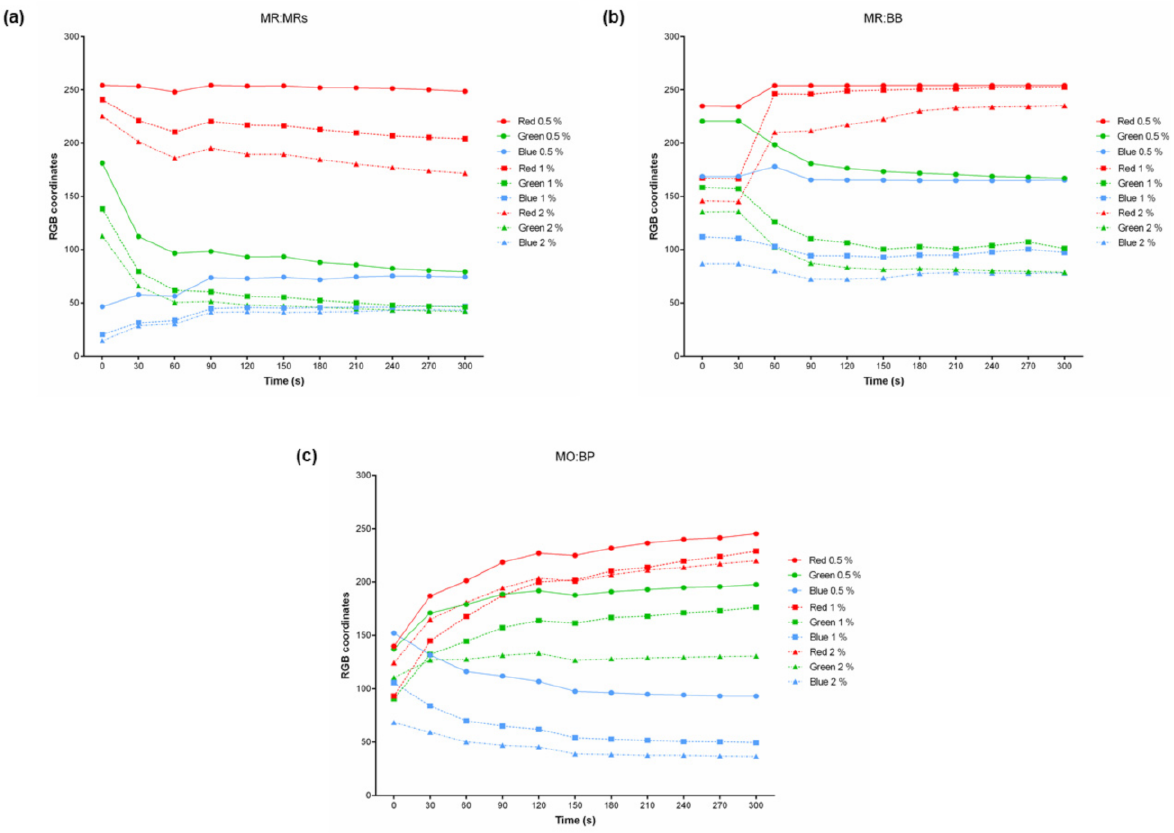
Figure 6. Influence of the concentration of indicators on the color change of ( a ) MR:MR-functionalized substrates, ( b ) MR:BB-functionalized substrates, and ( c ) MO:BP-functionalized substrates. Results are expressed in RGB color